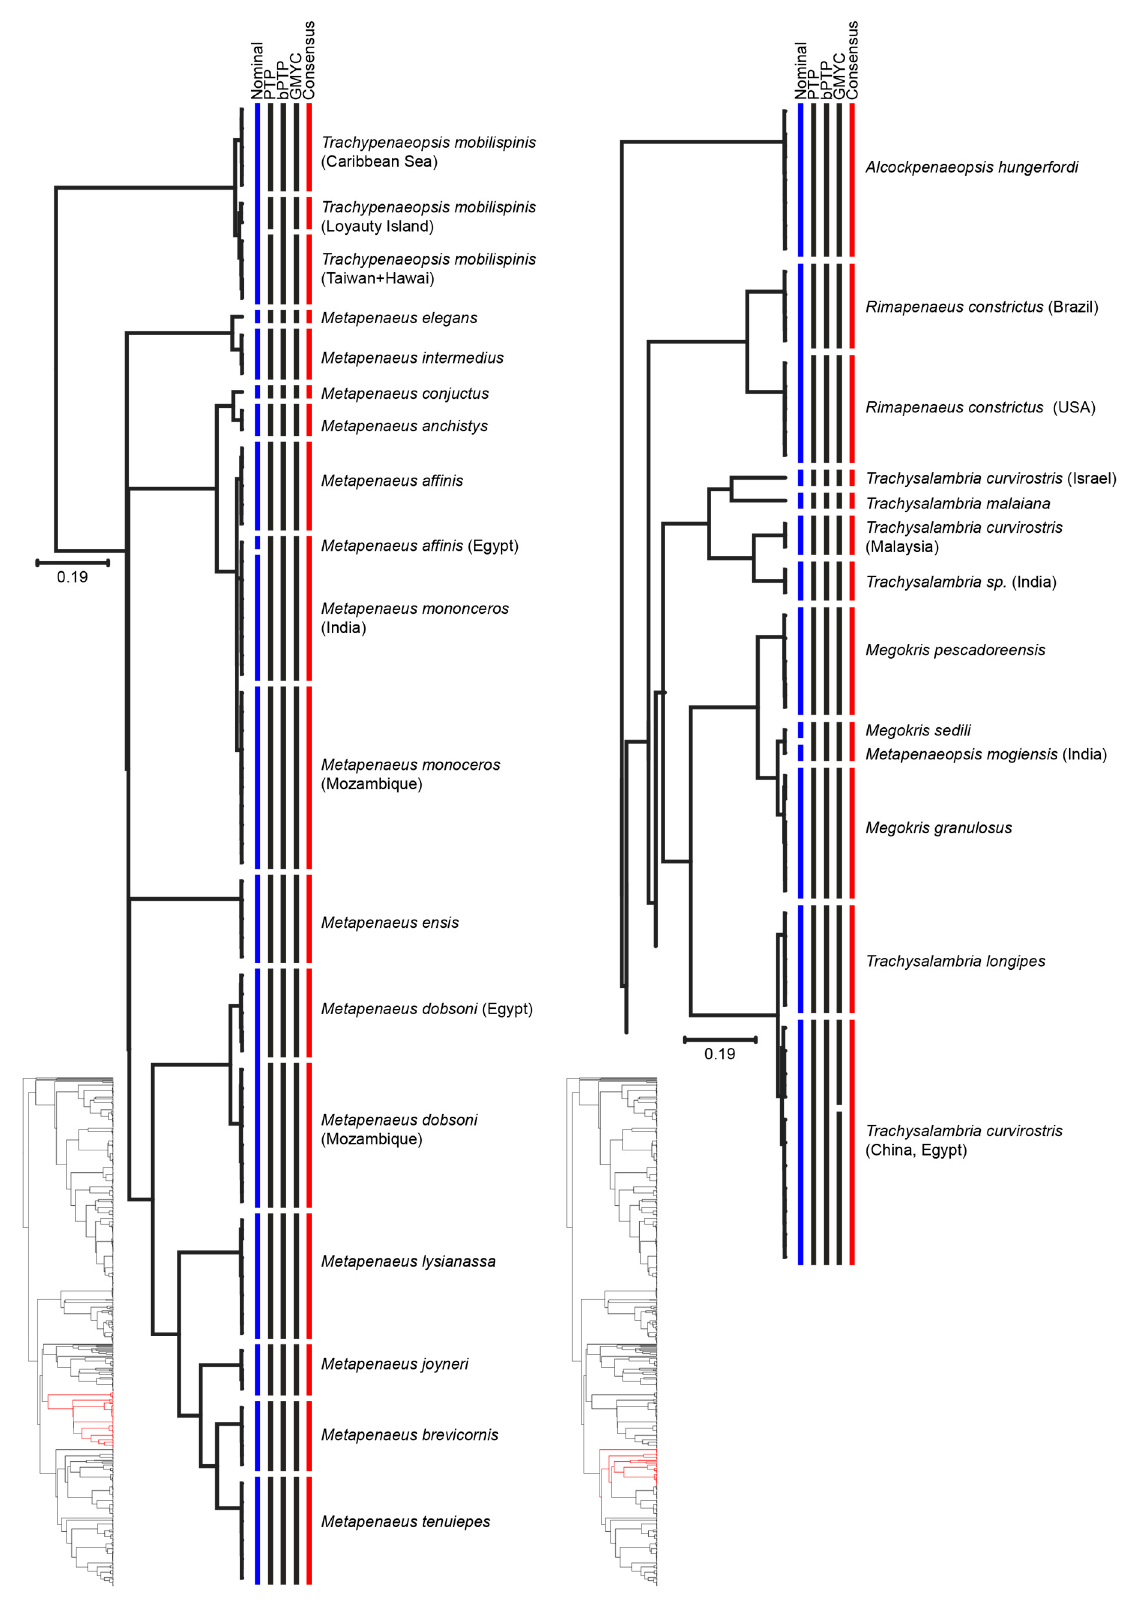
Figure 4. Bayesian tree showing the clustering of the MOTUs obtained by the species delimitation analyses for the genus Alcockpenaeopsis , Megokris , Metapenaeus , Rimapenaeus , Trachypenaeopsis , and Trachysalambria .